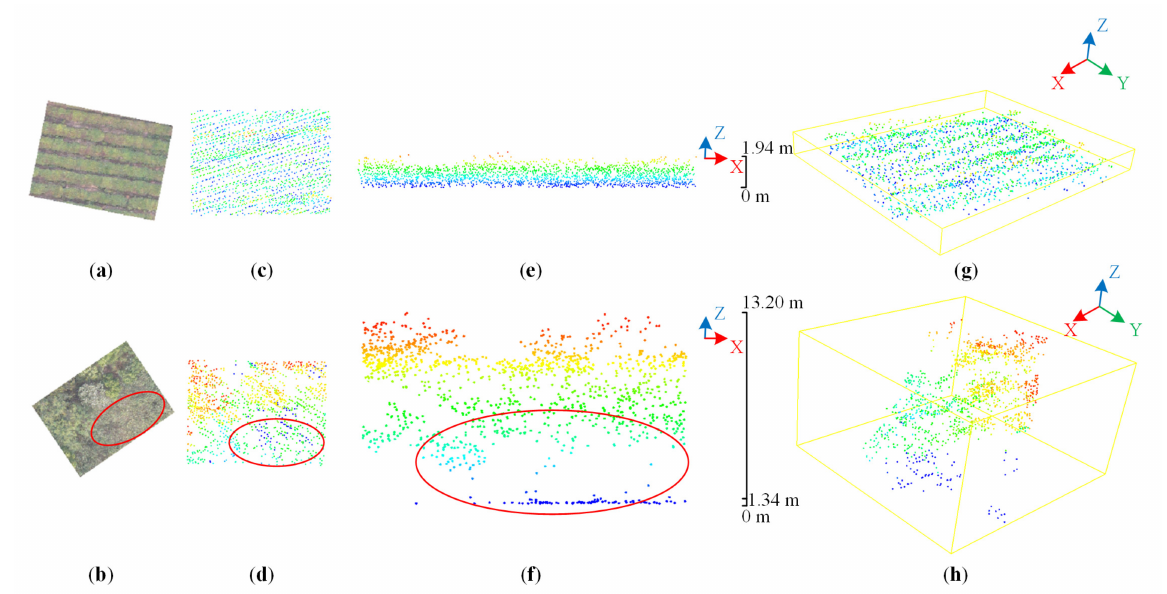
Figure 15. Comparison of tea trees and vegetation (incorrectly identified as tea trees in Model 2) based on UAV lidar data. ( a ) Digital image of tea trees; ( b ) digital image of vegetation; ( c ) horizontal picture of tea trees; ( d ) horizontal picture of vegetation; ( e ) vertical picture of tea trees; ( f ) vertical picture of vegetation; ( g ) 3D view of tea trees; ( h ) 3D view of